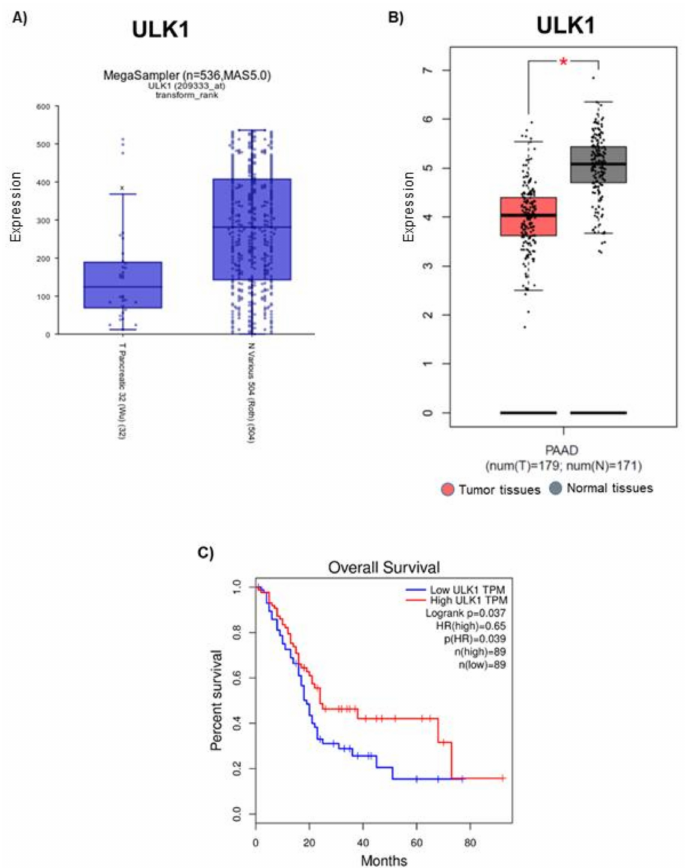
Figure 3. Expression of ULK1 in PDAC patient samples and its effect on overall survival rate. Basal expression of ULK1 in pancreatic tumor patients was evaluated by Cancer Genomic databases ( A ) R2 and ( B ) GEPIA. Data are represented as fold change with respect to healthy tissues. Role of ULK1 in ( C ) Overall patient survival was assessed using GEPIA database. * p ≤